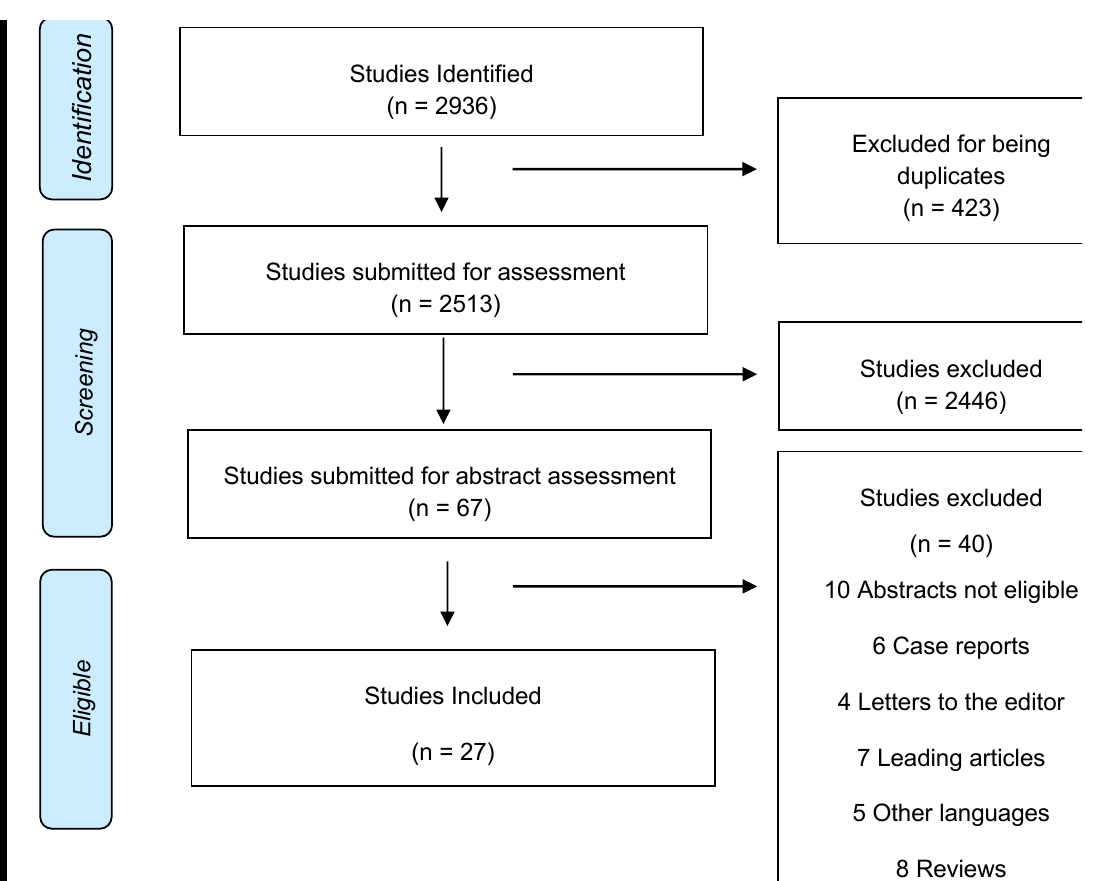
Figure 1 – Flowchart (Preferred Reporting Items foflow